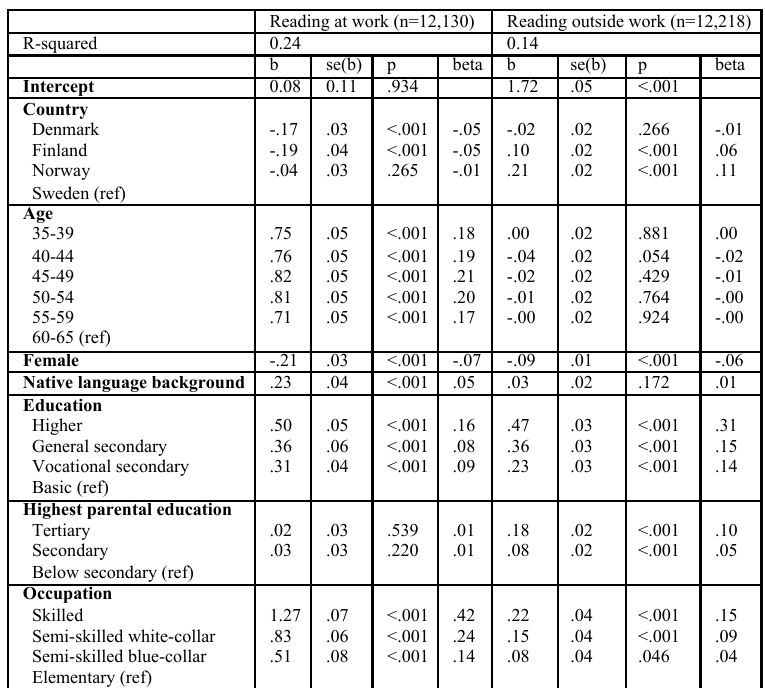
Table 1. Regression models for reading at and outside of work in four Nordic